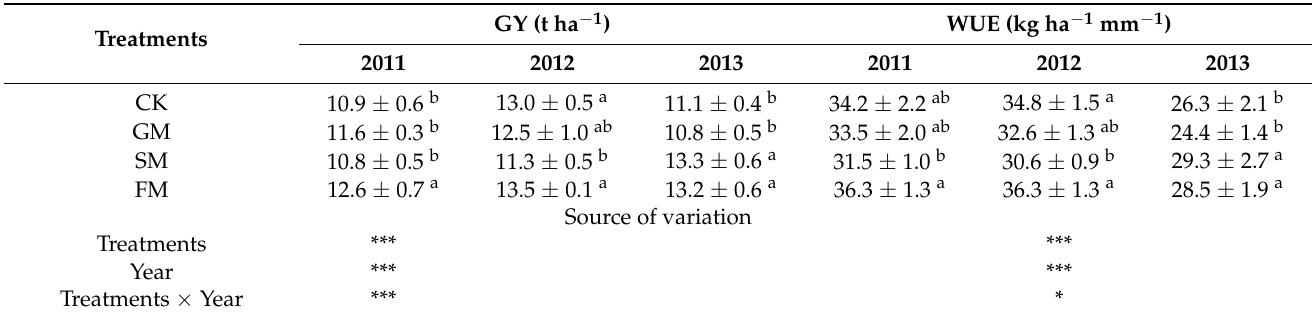
Table 2. Maize grain yield (GY) and water-use efficiency (WUE) under the non-mulched (CK), gravel mulching (GM), straw mulching (SM), and plastic film mulching (FM) treatments.